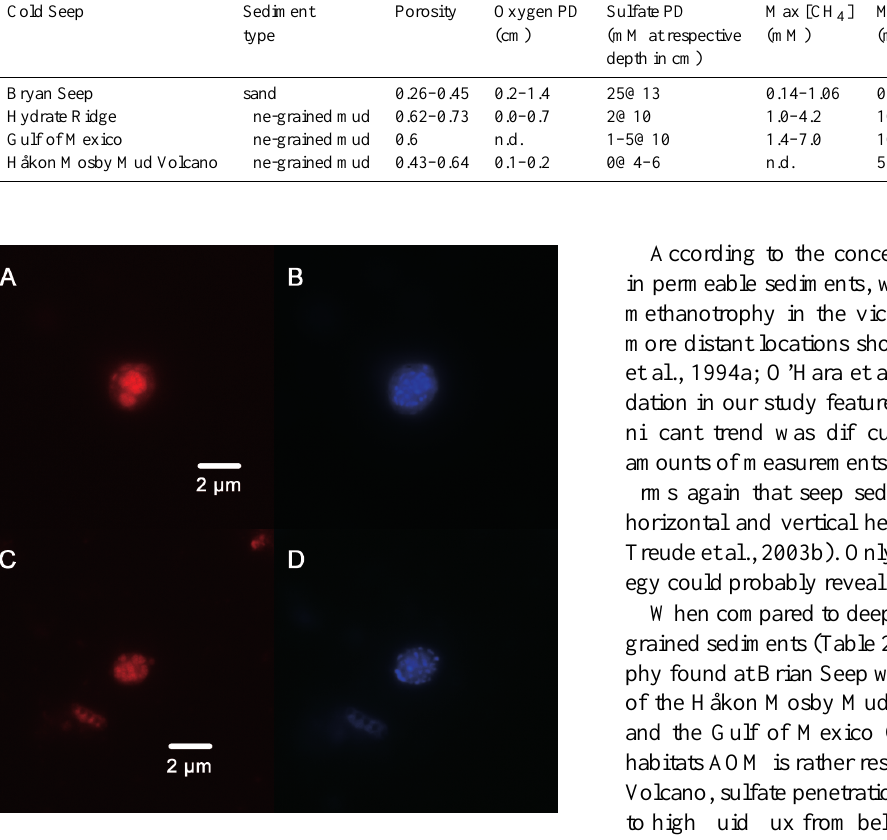
Fig. 4. (A, C) In situ identification of ANME-2 aggregates with flu- orescently labeled rRNA-targeted oligonucleotide probes (ALEXA 488-labeled). (B, D) DAPI counter staining. A scale bar is pro-